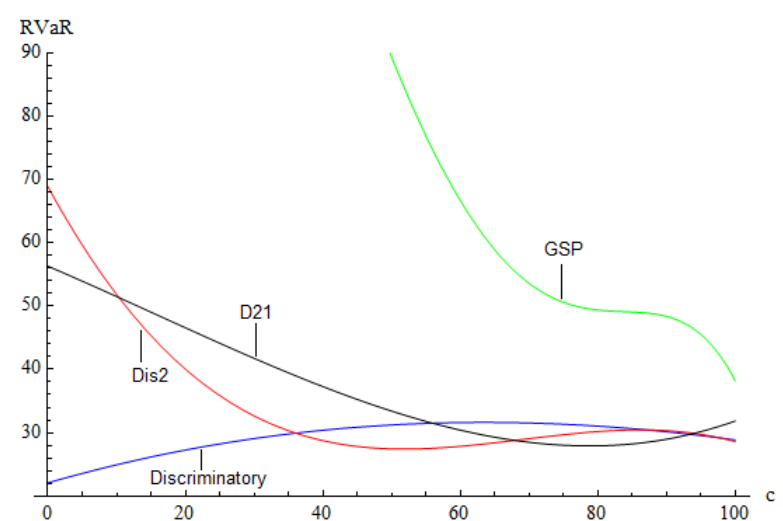
Figure 6. RVaR 0.95 of the three selected auction mechanisms of the parametric family corresponding to the vertices on the face where which γ 1 is maximum and GSP with 4 objects and 6